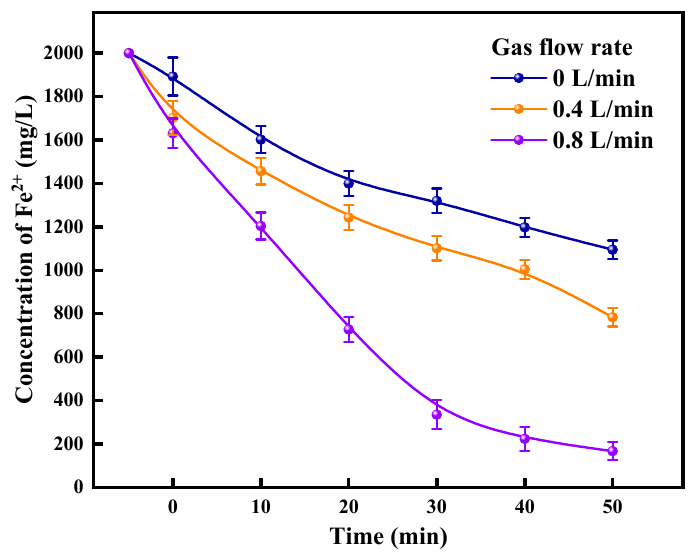
Figure 7. Influence of different flow rates on the oxidation of ferrous ions.